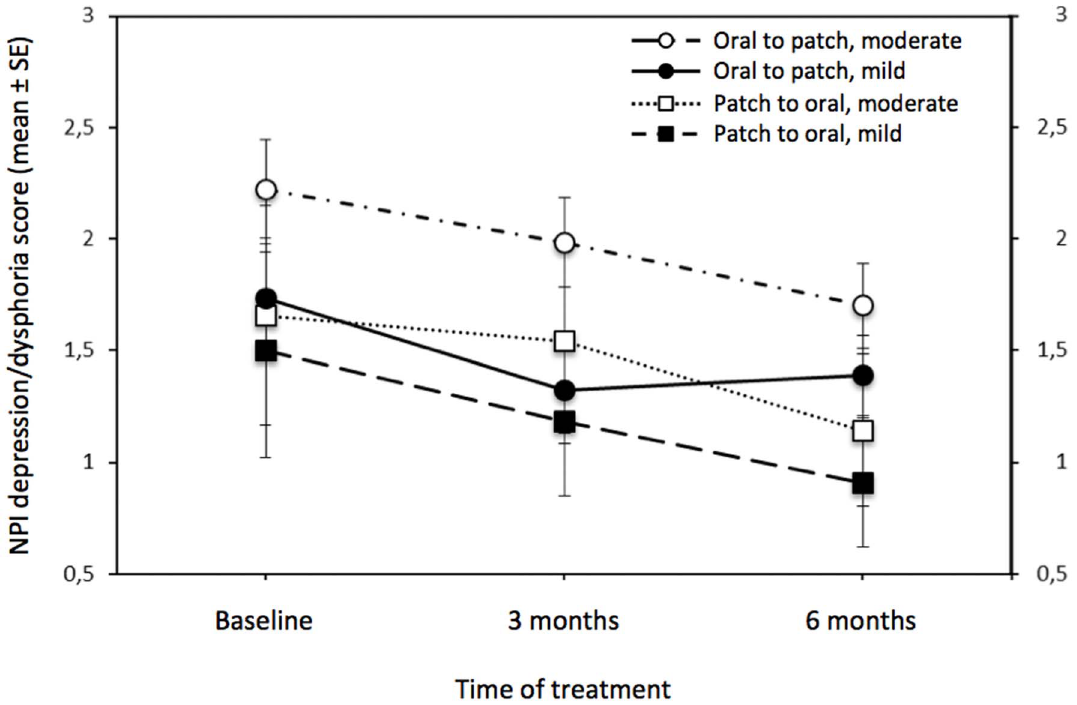
Figure 2. Changes of NPI depression/dysphoria score during ChEI switch. An analysis of variance with repeated measures indicates that the longitudinal course of depressive symptoms (i.e. NPI depression score changes during a 6-momth period) in mild to moderate AD patients performing for the first time a switch to another ChEI due to lack of response/reduced compliance, improves independently from AD severity and switch type (see the results section for statistic details). SE=Standard Error; NPI=Neuropsychiatric Inventory.